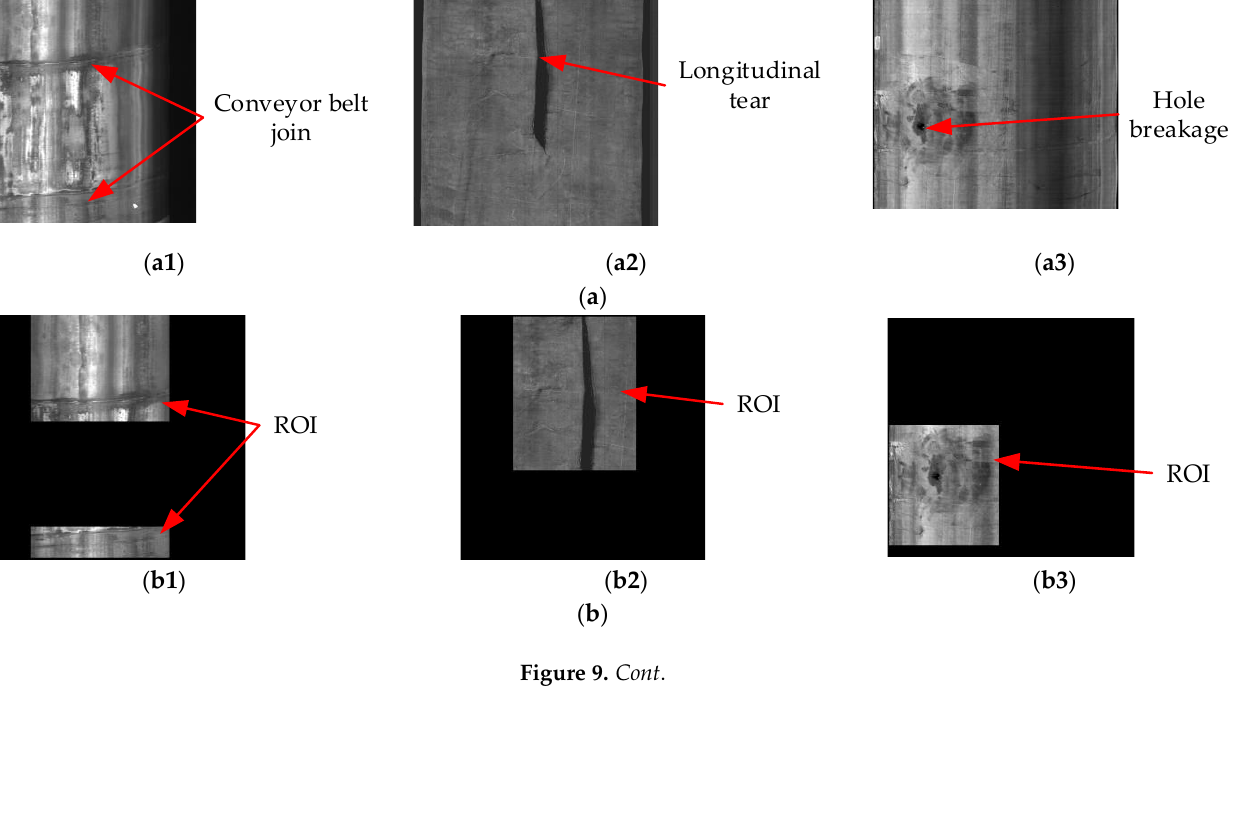
( u ) curve. ( h ) B VD ( v ) curve. ( i ) B HM ′ ( u ) curve. ( j ) B VD ′ ( v ) curve. 1 1 1 1